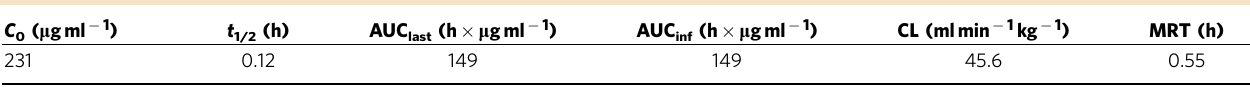
Table 1 | Pharmacokinetics parameters determined after IV administration of 125 mgkg (cid:2) 1 of ERG240 in mice. C 0 ( l gml (cid:2) 1 ) t 1/2 (h) AUC last (h (cid:3) l gml (cid:2) 1 )